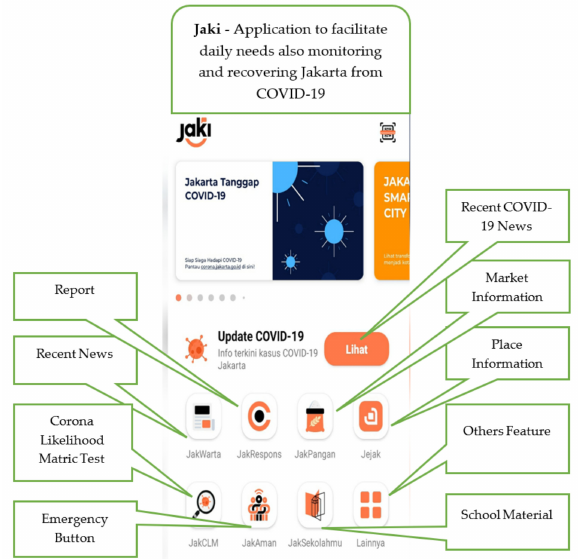
Figure 4. The appearance of the application “Jaki”. Source: